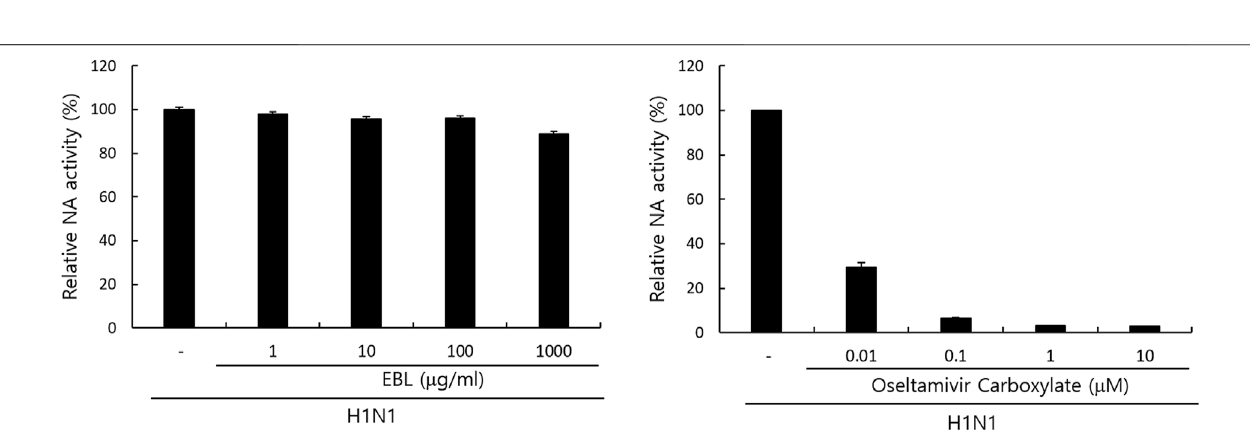
FIGURE 6 | Effect of EBL on neuraminidase activity. EBL or oseltamivir carboxylate at indicated concentrations was mixed with H1N1 IAV in 96-well black plates. Each mixture was added with 200 µM NA-Fluor Substrate, incubated for 1 h for 37 ° C, and terminated by NA-Fluor stop solution. The NA activities were measured from the valuesina fl uorescentspectrometer usinganexcitationwavelengthof365 nm and anemission wavelengthof445 nm.Thedatarepresent themean ±SDbased on three independent experiments. Statistical signi fi cance was assessed via an unpaired Student ’ s T-test. *** p < 0.0005, ** p < 0.001, and * p < 0.005.